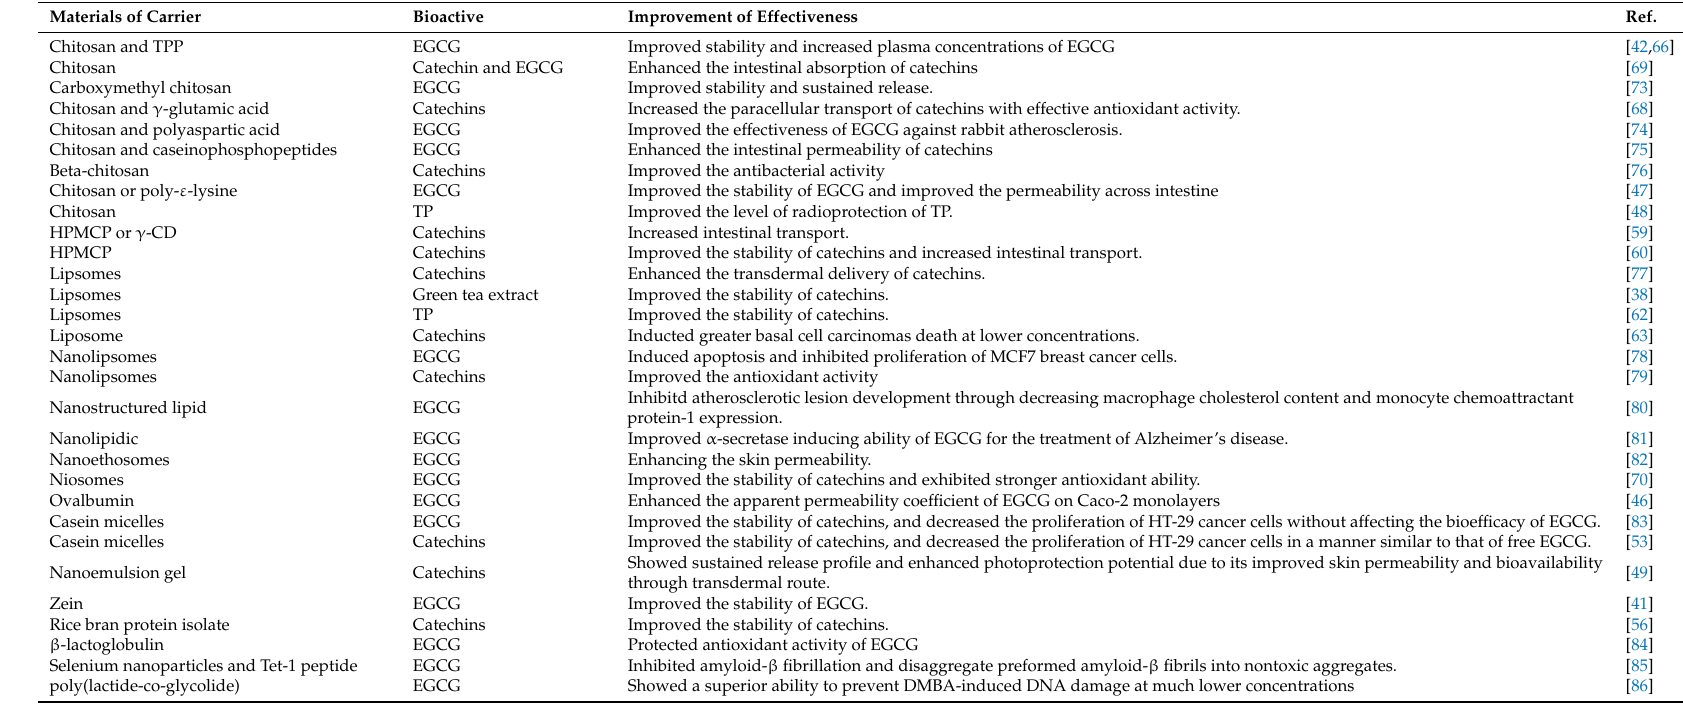
Table 1. Various carriers of catechins and their improvement of